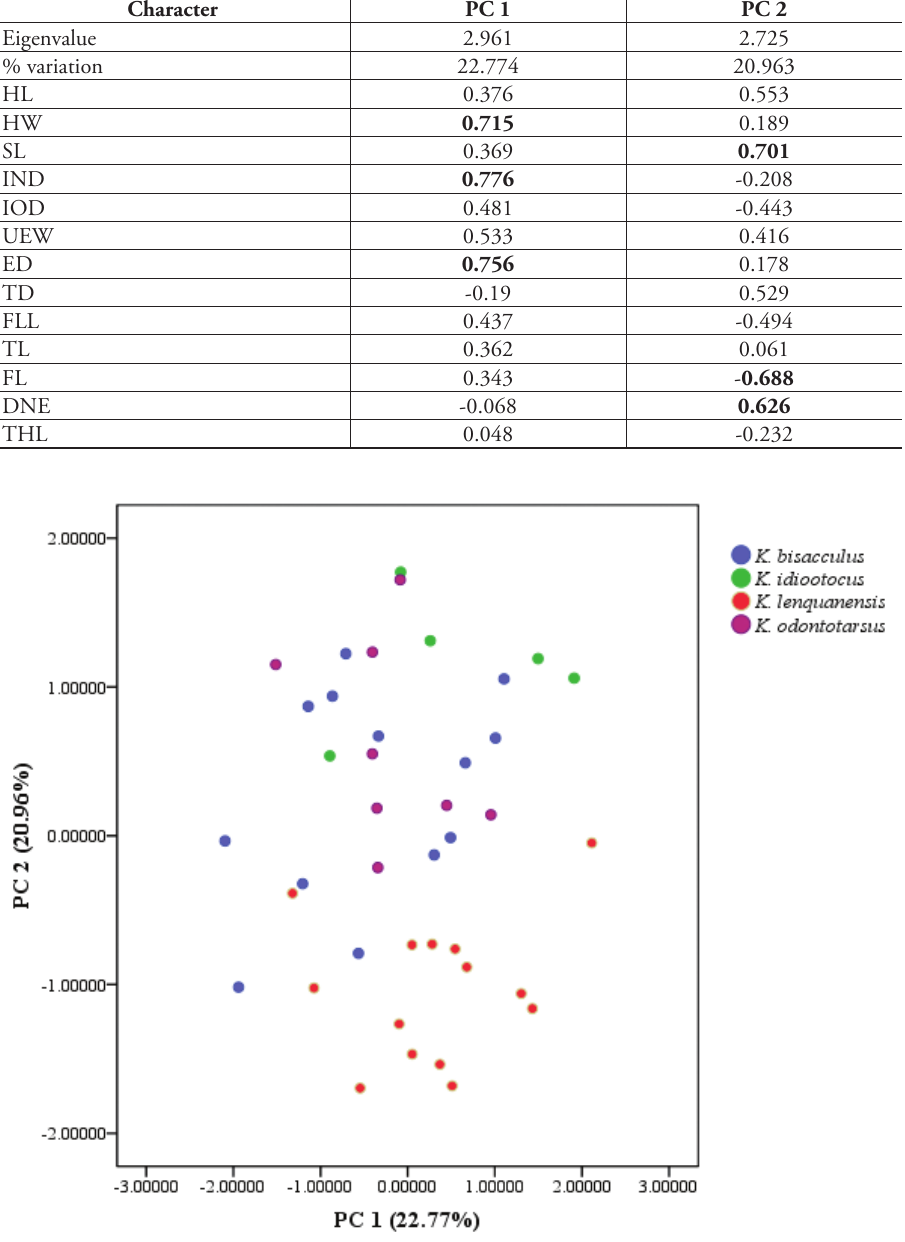
Figure 3. Scatterplot of principal components 1 and 2 of size-adjusted morphometric data for males of K. lenquanensis sp. n., K. idiootocus , K. bisacculus , and K. odontotarsus